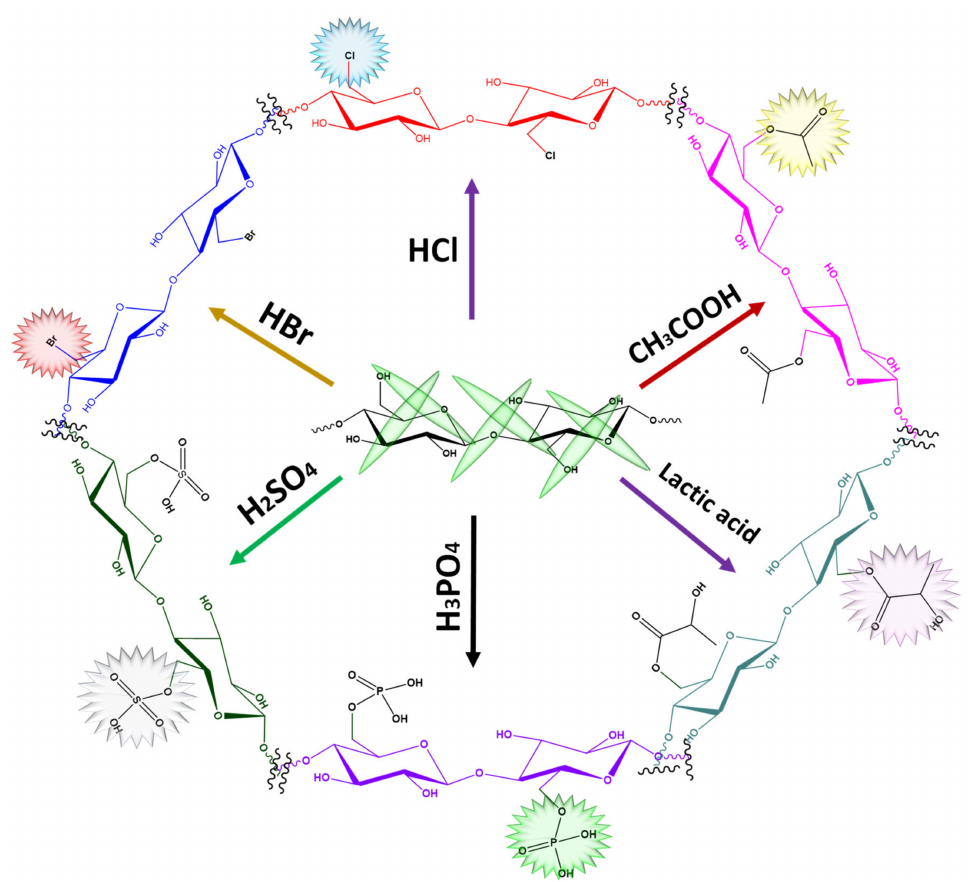
Figure 4. Common surface functionalization techniques of